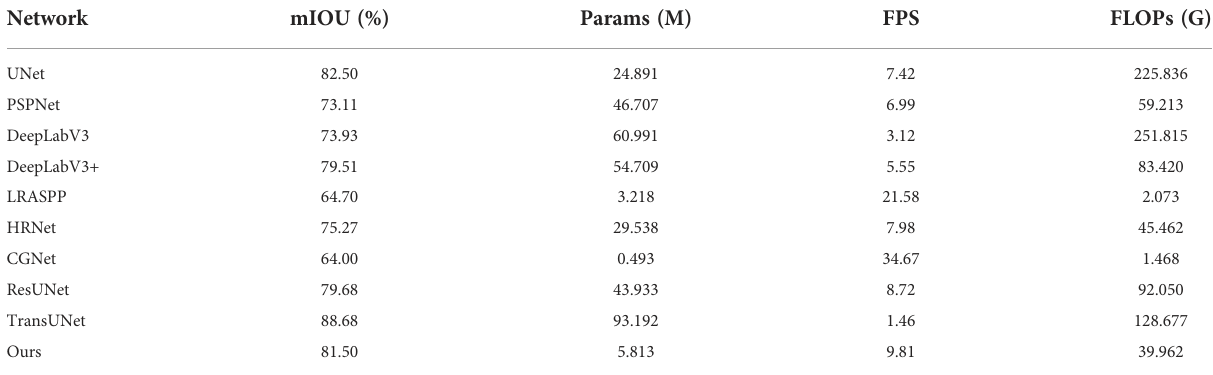
TABLE 6 Comparison with other networks.